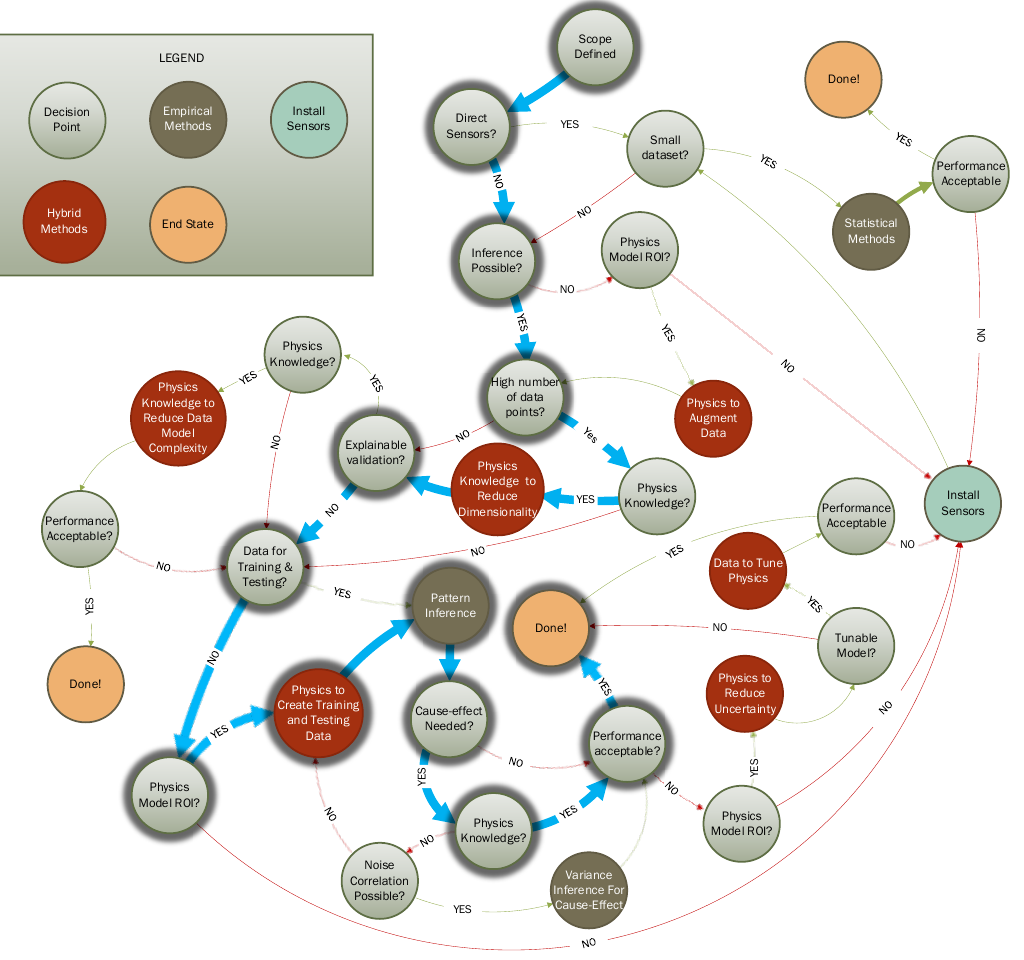
Figure 8. Revised strategy applied to HPCI anomaly